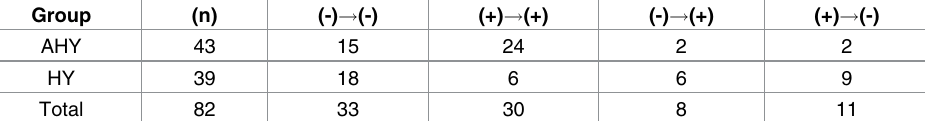
Table 4. Serostatus histories for 82 mallards captured on multiple occasions during the winter of 2014/15in Anchorage, Alaska. Serostatus of juvenile(HY) and adult (AHY) mallardswas determinedto be either negative(-) or positive (+) through bELISA.